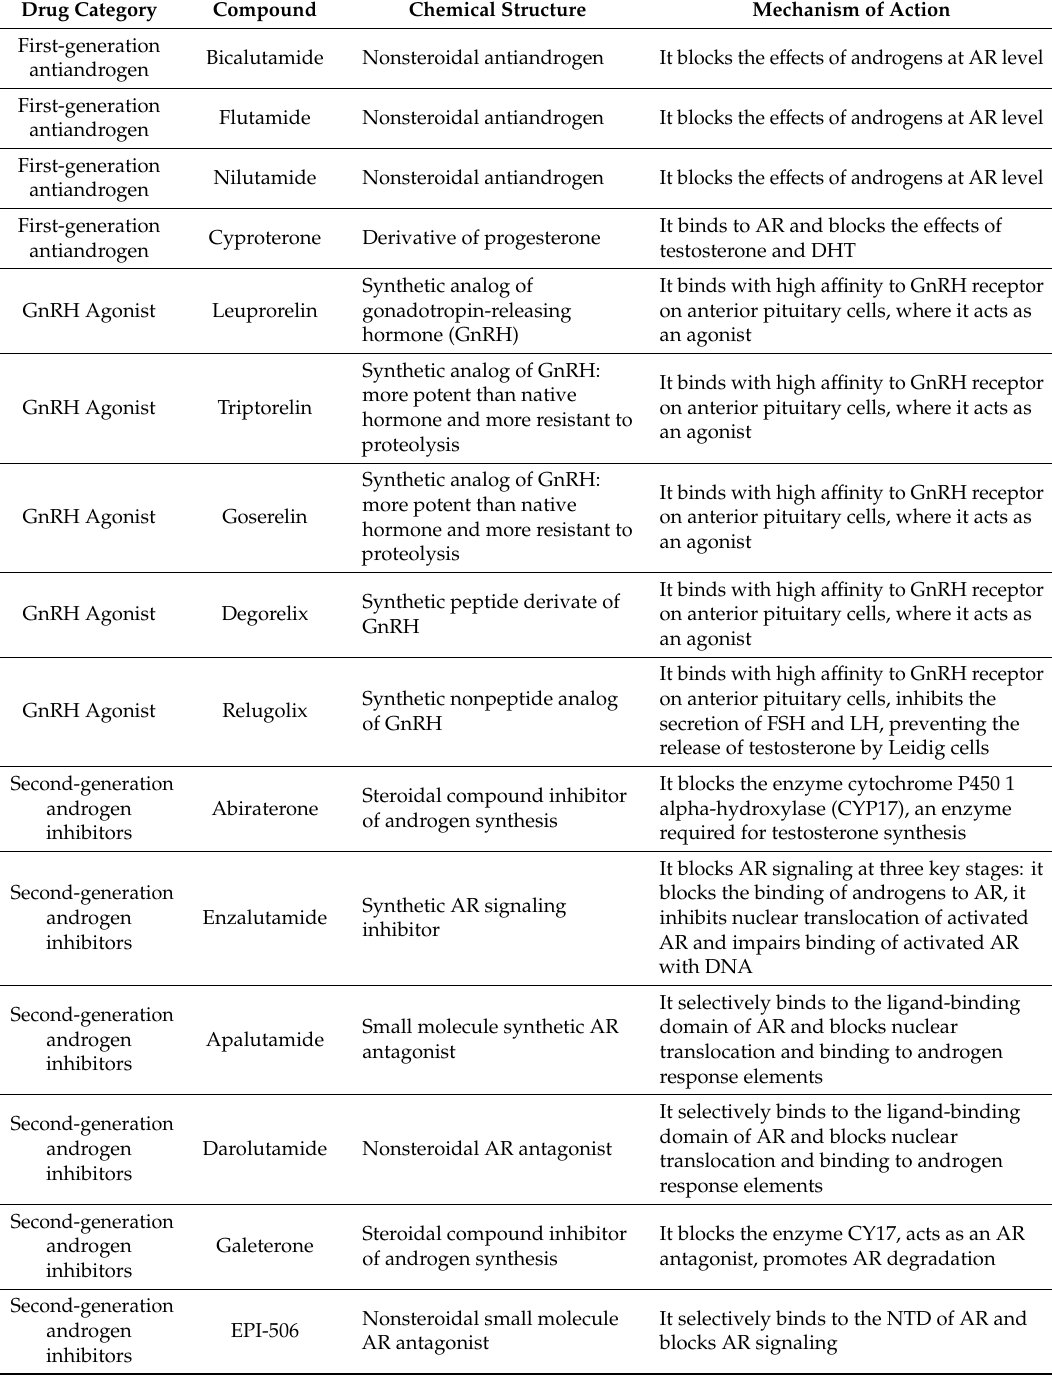
Table 2. Di ff erent drugs used as androgen inhibitors for prostate cancer